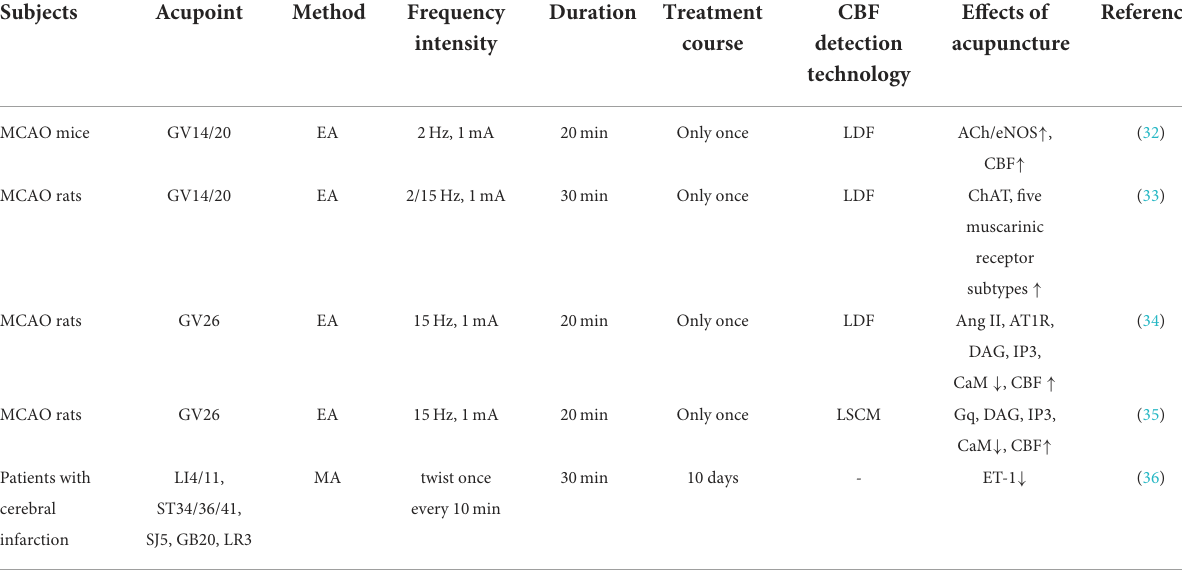
TABLE 2 Acupuncture modulates the release of vasoactive substance. Subjects Acupoint Method Frequency